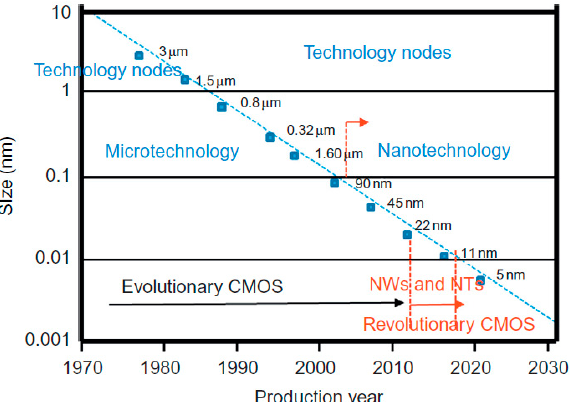
Figure 1. Miniaturization of the transistor gate length in different technology nodes and production years [22].